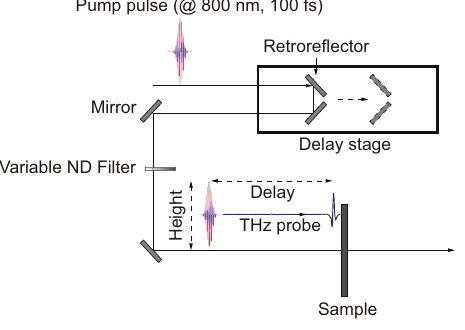
Fig. 5 Schematic illustration of experimental setup. Loss boundary height and delay are adjusted by tuning the pump fl uence and positions of retrore fl ectors for pump and terahertz probe